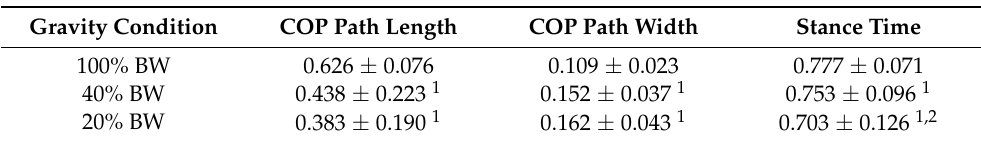
Table 3. Normalized average and standard deviation COP path length, COP path width, and stance time across each gravity